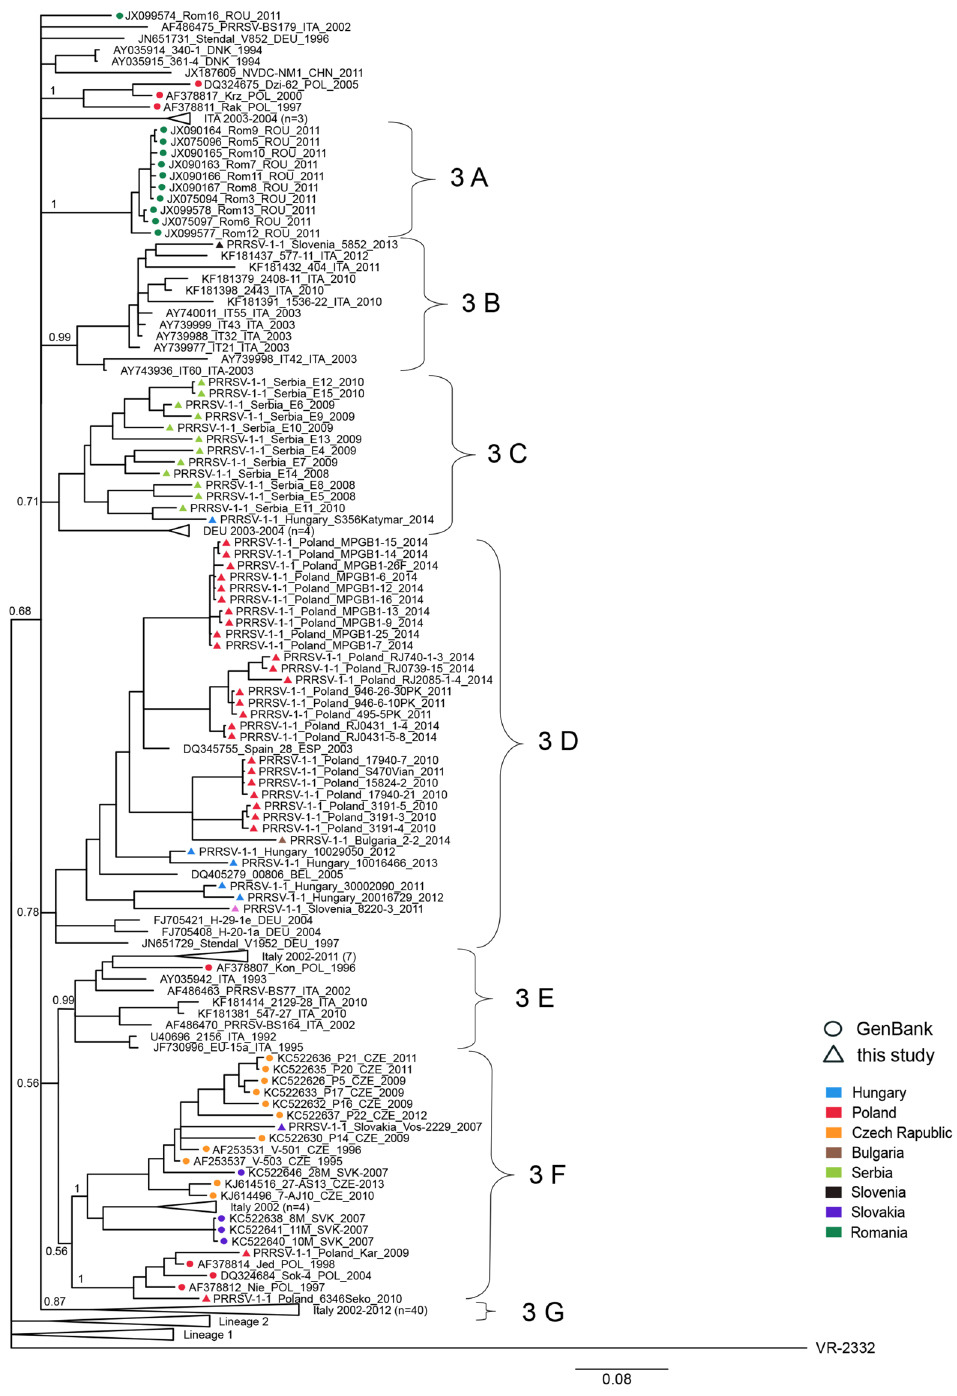
Figure 5. Phylogenetic tree of lineage 3 ORF5 sequences constructed in MrBayes 40 . PRRSV 2 prototype strain VR2332 (AY150564) was used as an outgroup. Some minor clusters were collapsed for clarity. Posterior probability values supporting main nodes were shown. Geographical origin and year of isolation were indicated for each sequence. Braces indicate clades 3 A–3